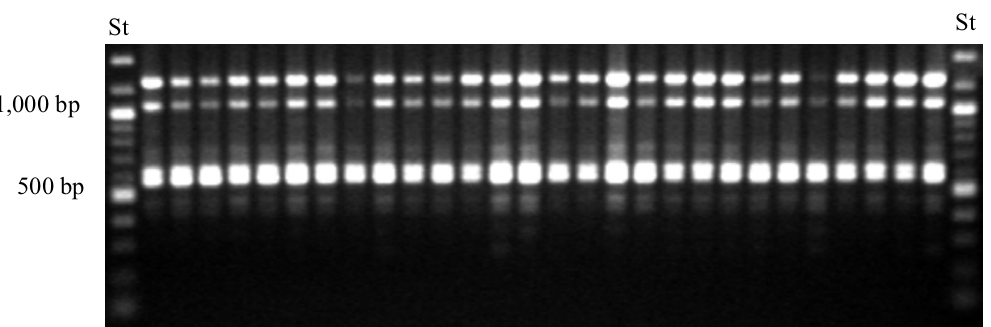
Fig. 1. Example of banding patterns obtained using a single 10-mer primer to amplify the DNA of 28 isolates of Phaeomoniella chlamydospora (St, standard).